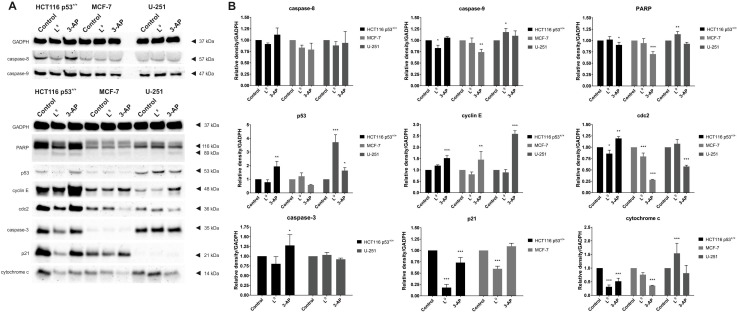
The effect of L9 on the expression of the proteins: GADPH, PARP, caspase-3, 8, 9, p53, cyclin E, cdc2, p21, and cytochrome c, in the HCT116 p53+/+, U-251 and MCF-7 cells.(A). Densitometric analyses of western blot images. Expression level signals are relative to GADPH expression. Data were analyzed using one-way ANOVA with Bonferroni’s post-hoc test: *p<0.05, **p<0.01, ***p<0.001 compared to the control (B).